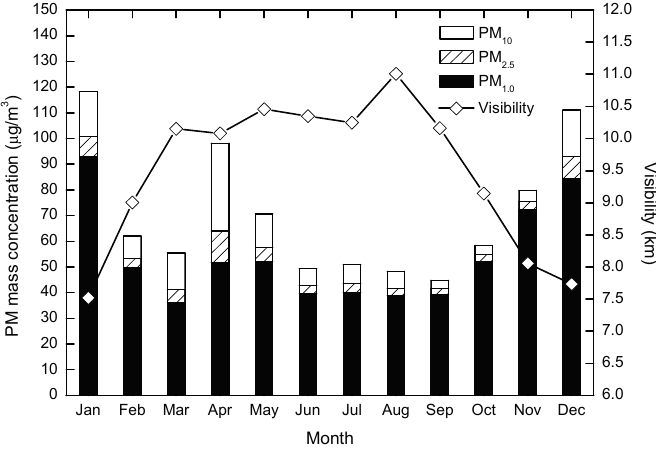
Figure 9. Variations in monthly mass concentrations of PM 10 , PM 2.5 , and PM 1.0 related to horizontal